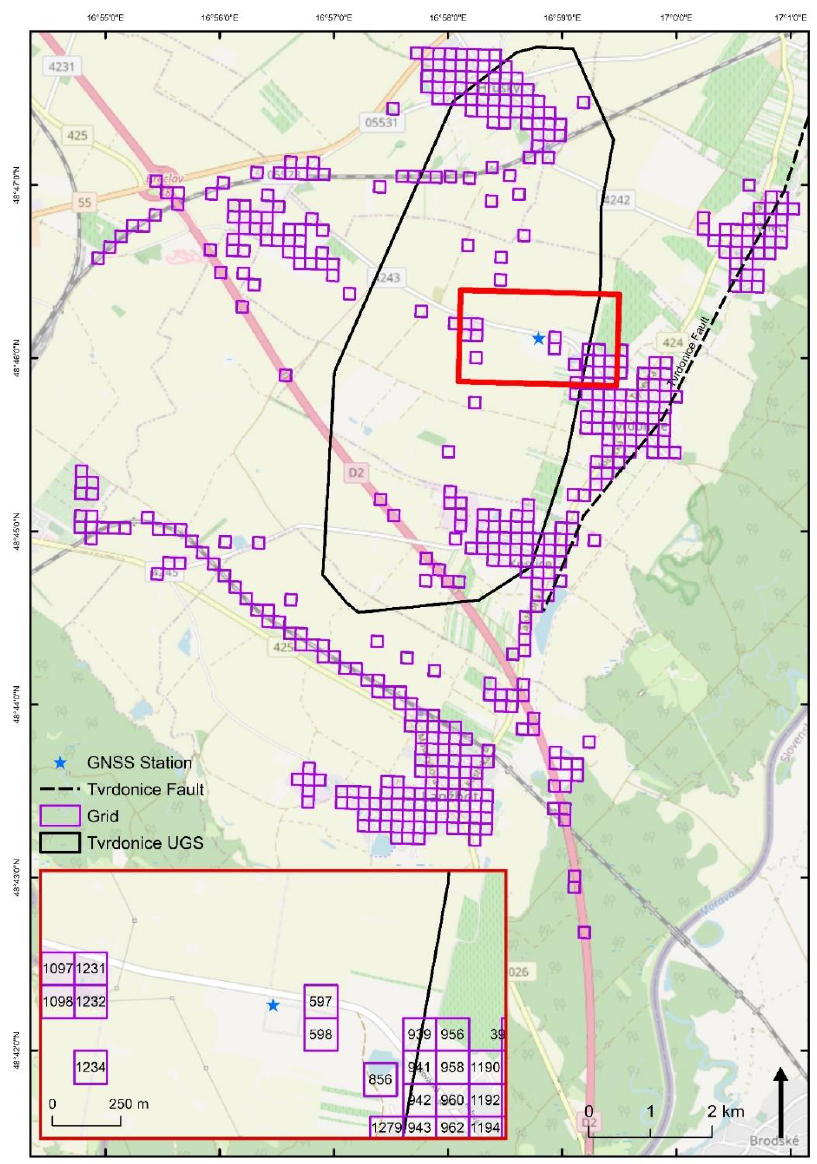
Figure 5. Spatial distribution of patches converted to U–D and E–W directions. A blue star indicates the location of the GNSS station.